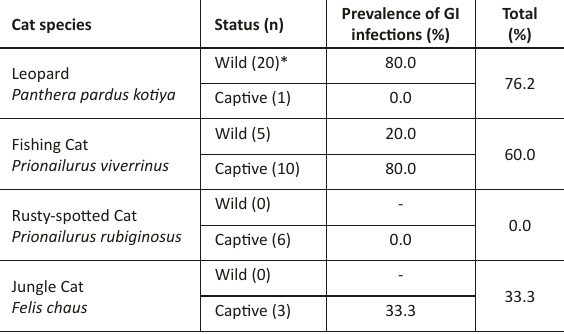
Table 1. Number of fecal samples collected from wild and captive cat species from the five sampling sites